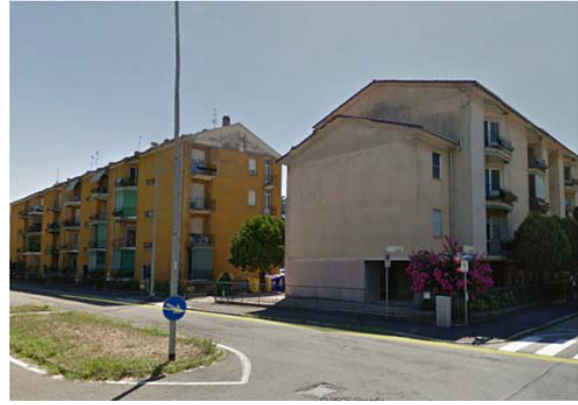
Figure 5: Buidings in Pavia